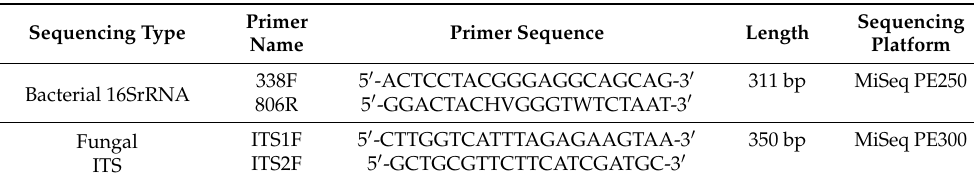
Table 1. Sequencing type and primer